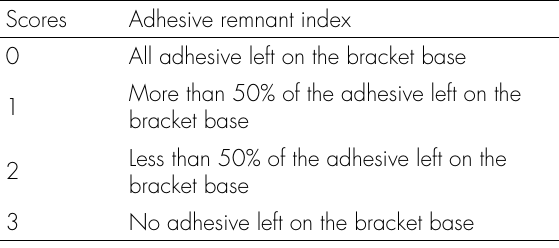
Table I. Adhesive remnant index